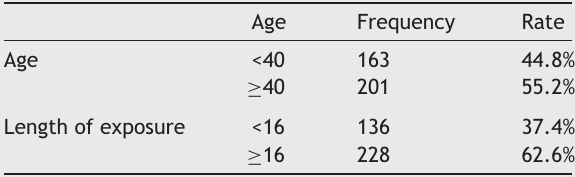
Distribution of workers by age and length of expo-